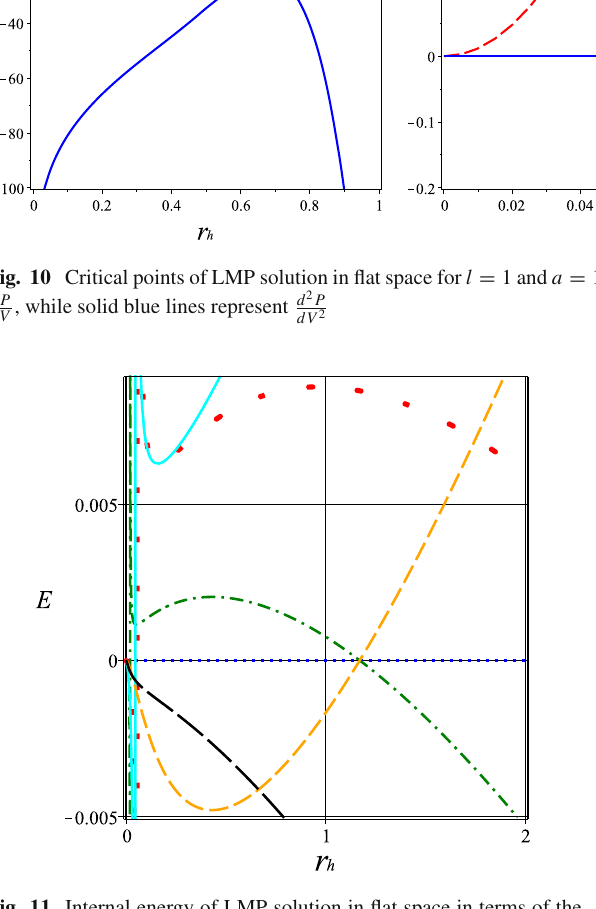
Fig. 11 Internal energy of LMP solution in flat space in terms of the black hole horizon for l = 1 and a =